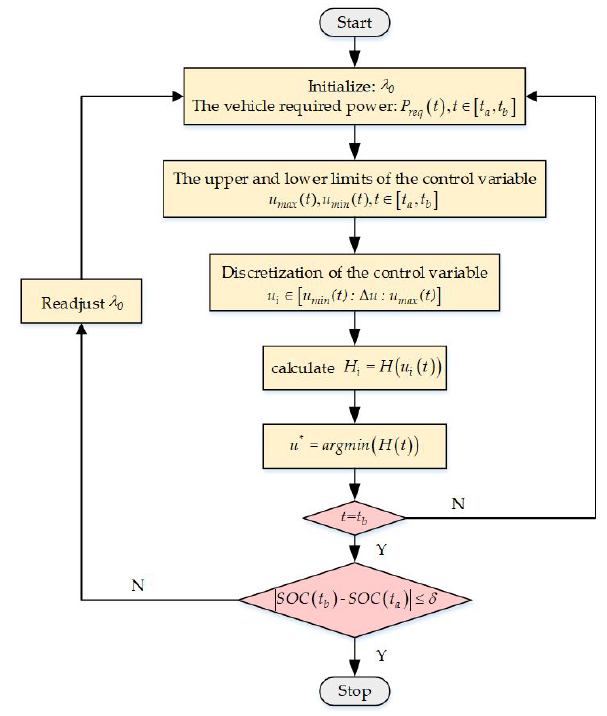
Figure 5. The flow chart of the PMP-based